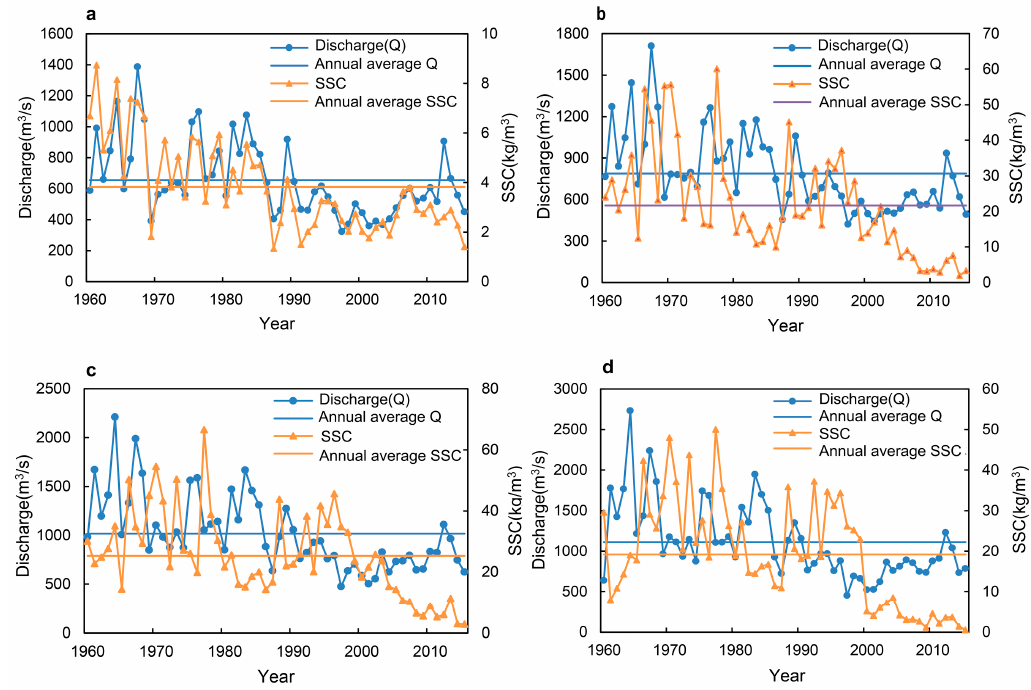
Figure 6. Changes in annual mean water discharge and suspended sediment concentration at Toudaoguai station.